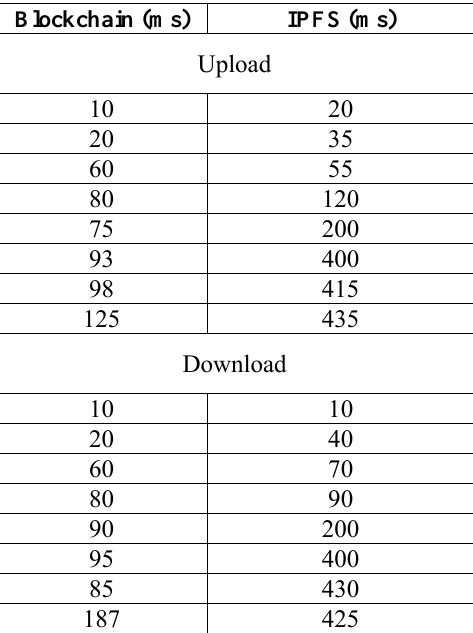
Table 5.1. Comparison of upload and download speed between IPFS and